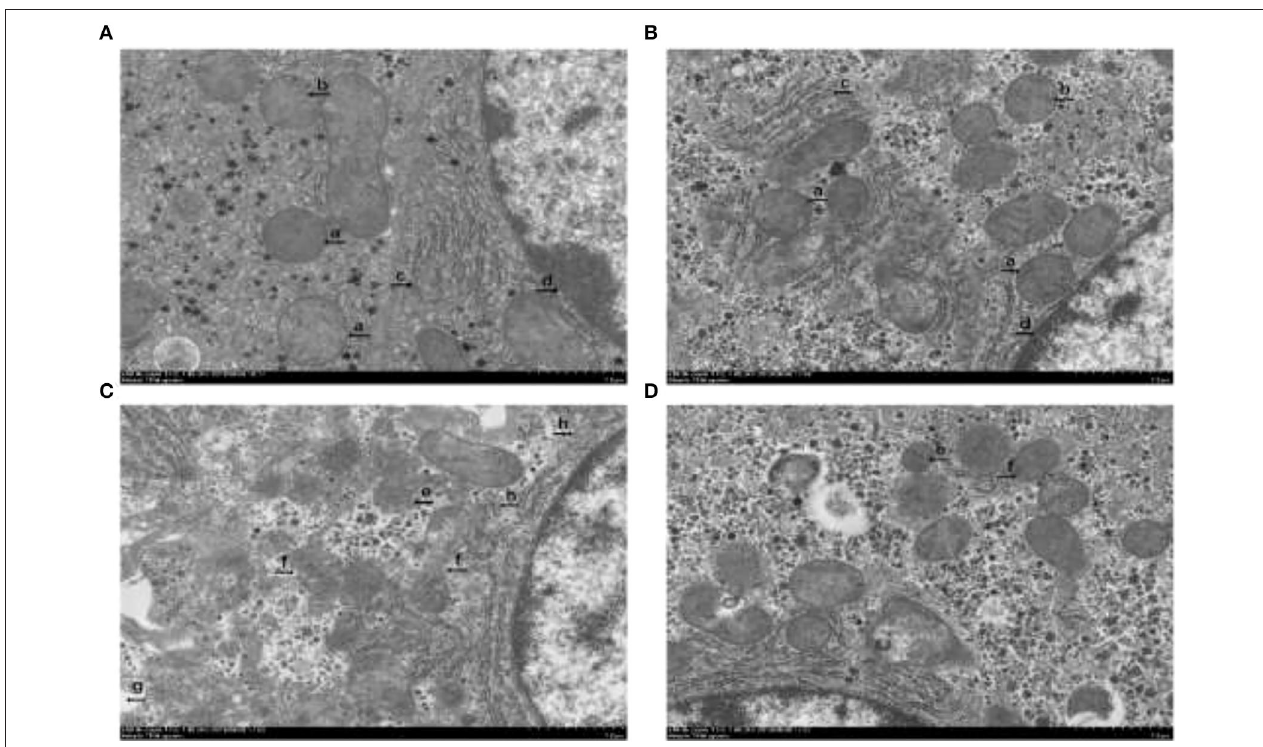
FIGURE 2 | The effect of dietary holly polyphenols extracts (HPE) supplementation on hepatocyte ultrastructure after 7 d diquat challenge in weanling pigs. Representative hepatocyte ultrastructures are shown. (A) Pigs fed a basal diet and treated with 0.9% NaCl solution. (B) Pigs fed a HPE diet and treated with 0.9% NaCl solution. (A) and (B) were no obvious ferroptosis characteristics. Presented as complete mitochondria (a), mitochondria with distinct cristae (b), normal rough endoplasmic reticulum (c), karyotheca integrity (d). (C) Pigs fed the same basal diet and challenged with diquat. Significant ferroptosis characteristics were